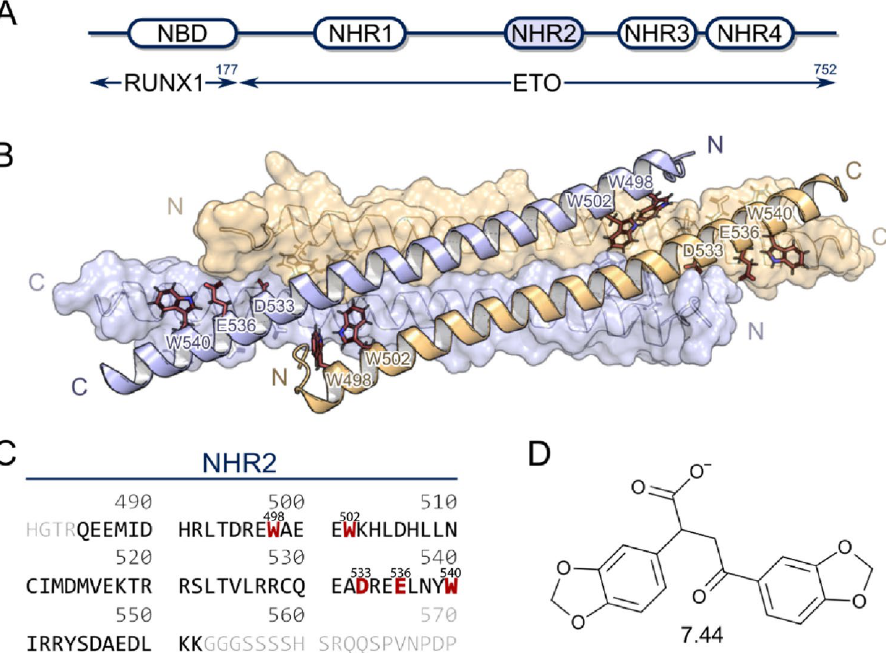
Figure 1. Schematic representation of RUNX1/ETO tetramerization. ( A ) Depiction of the chimeric RUNX1/ ETO fusion protein containing the nucleotide-binding domain (NBD) and four nervy homology regions (NHR). The NHR2 domain (marked in blue) mediates homo-tetramerization. ( B ) X-ray crystal structure (PDB ID 1WQ6) of the NHR2 domain. For the clarity of the tetrameric α-helical bundle, one antiparallel α helical pair is shown in ribbon view and the other in surface view. The five predicted hot spot residue 11 side chains (W498, W502, D533, E536, and W540) are shown in stick representation and colored by elements ( C ) Primary amino acid sequence of the NHR2 domain shown in black, hot spot residues are colored in red, other ETO residues in gray. ( D ) Molecular structure of 7.44